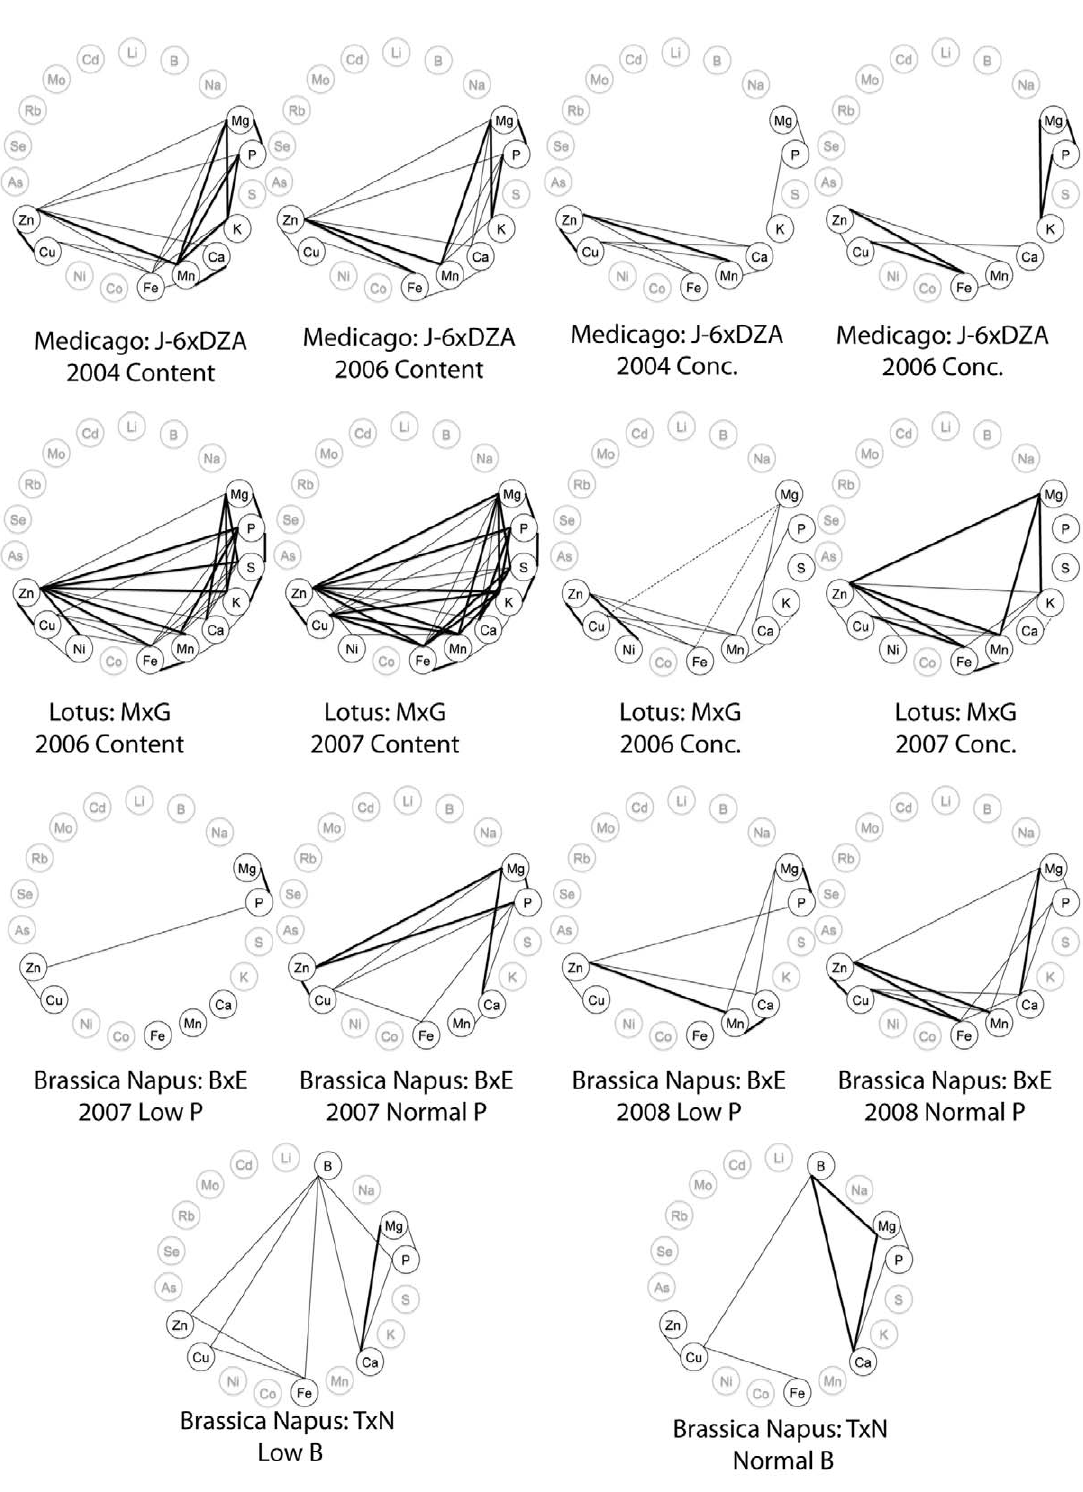
PLoS ONE | www.plosone.org 8 April 2012 | Volume 7 | Issue 4 |